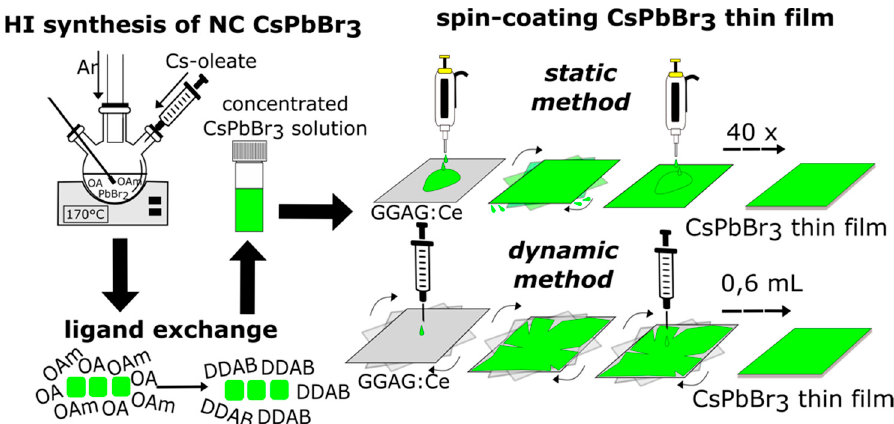
Figure 2. Schematic representation of the synthesis and spin-coating processes; hot injection (HI) synthesis, ligand exchange of oleic acid (OA) and oleylamine (OAm) for dioleyldimethylammonium bromide (DDAB) and static and dynamic spin-coating processes.